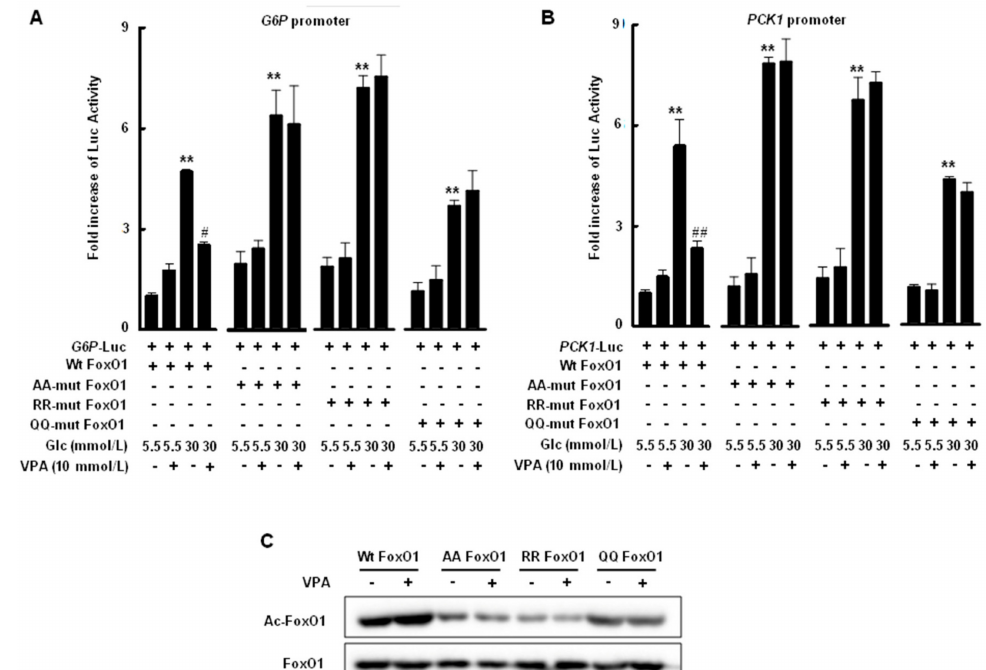
Figure 4. VPA reduced transcriptional activity of FoxO1 via acetylation. HepG2 cells were co-transfected with expression vectors for wild-type (wt) FoxO1, AA-mutant FoxO1, RR-mutant FoxO1, or QQ-mutant FoxO1, as well as luciferase vectors conjugated with G6P promoter ( A ) or PCK1 promoter ( B ). VPA administration decreased hyperglycemia-induced promoter activity in HepG2 cells transfected with wild-type FoxO1, but not mutant FoxO1. The graphs show the mean ± SEM of three independent experiments (** p < 0.01 vs. wt FoxO1 in 5.5 mmol/L glucose; # p < 0.05, ## p < 0.01 vs. wt FoxO1 in 30 mmol/L glucose); ( C ) VPA administration under hyperglycemic conditions resulted in increased FoxO1 acetylation in HepG2 cells transfected with wt FoxO1, but not mutant FoxO1. 2.5. Hyperglycemic Conditions Induce Interactions between FoxO1 and HDAC3, as Well as FoxO1 and HDAC4, Which Regulate the Transcriptional Activity of